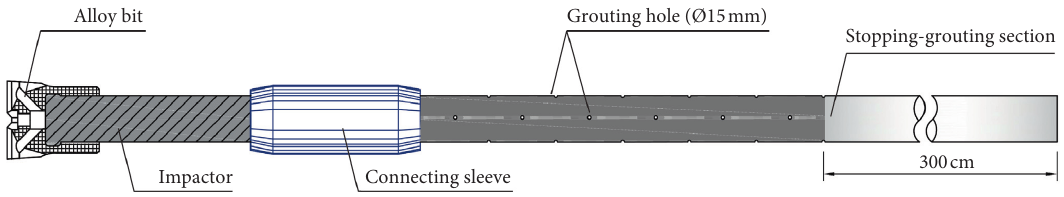
Figure 11: Structure of self-propelled hollow grouting pipe